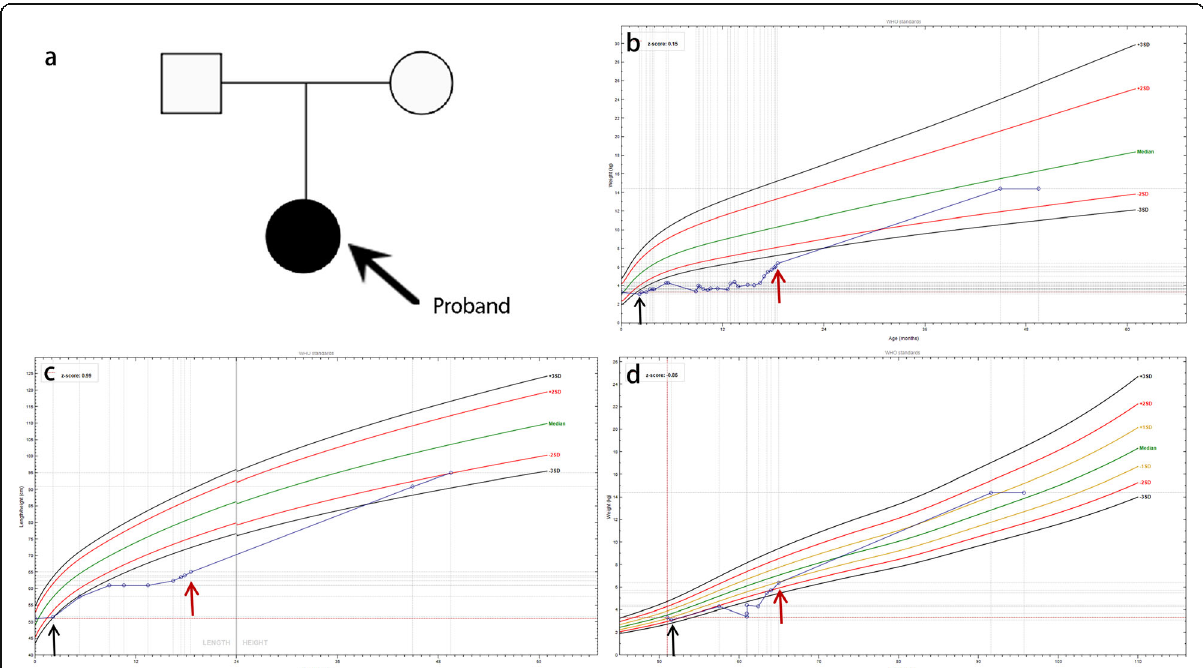
Fig. 3 Pedigree of the proband ’ s family and the growth curve of the proband. a Pedigree of the affected family. The proband is indicated with a black arrow; it could be an autosomal recessive disease. b WAZ of the proband ’ s growth parameters. c HAZ of the proband ’ s growth parameters. d WHZ of the proband ’ s growth parameters. Short black arrows indicate the time when the proband received parenteral nutrition, and the red arrows indicate the time point when the proband started a fat-restricted